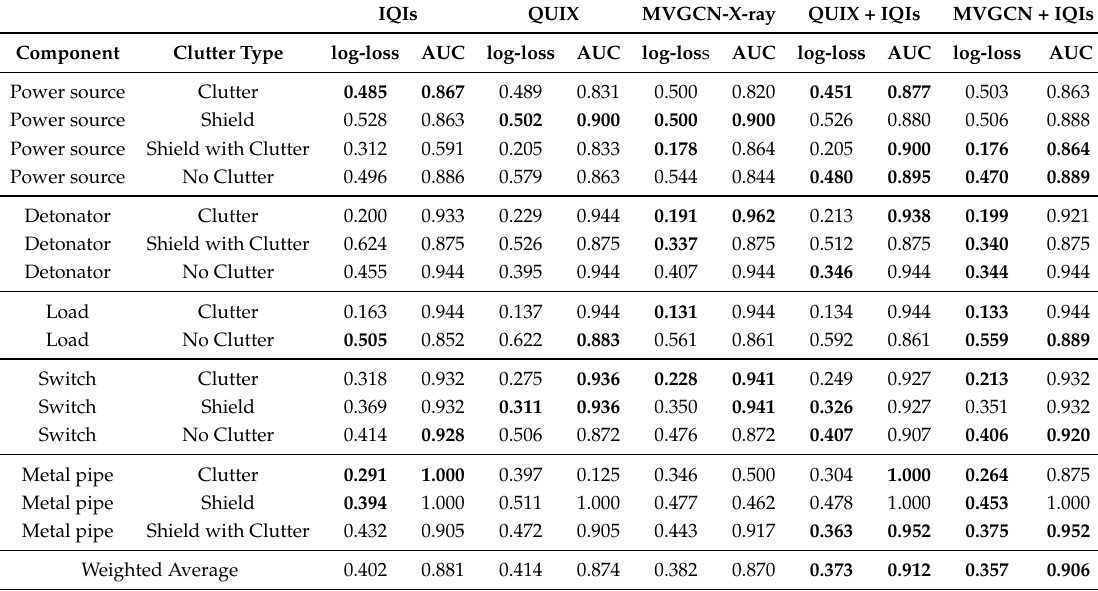
Table 9. Median log loss and AUC scores across 1000 train-test trials on different component-clutter combinations. The best two feature groups for each component-clutter category are boldfaced. IQI, image quality indicator; QUIX, quality inspectors of X-ray